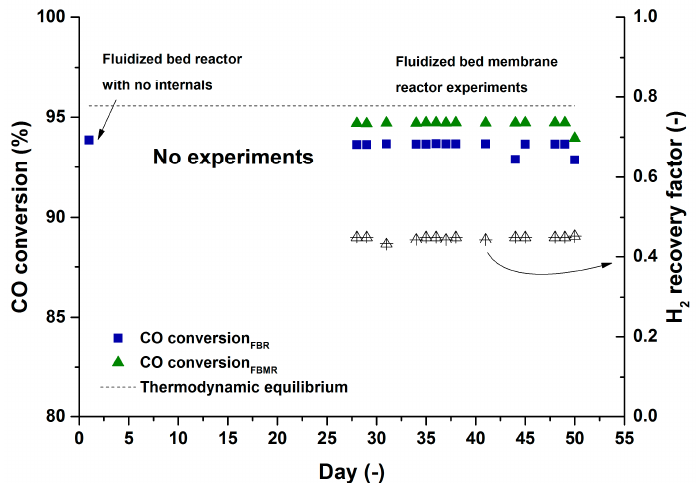
Figure 5. The long term performance of the a fluidized bed membrane reactor (FBMR) module in comparison with a fluidized bed reactor (FBR) module over 900 h of continues work. Temperature: 400 ˝ C, CO (10%), H 2 O (30%), N 2 balance, U/U mf : 2.1, P perm : 30 mbar, P:1